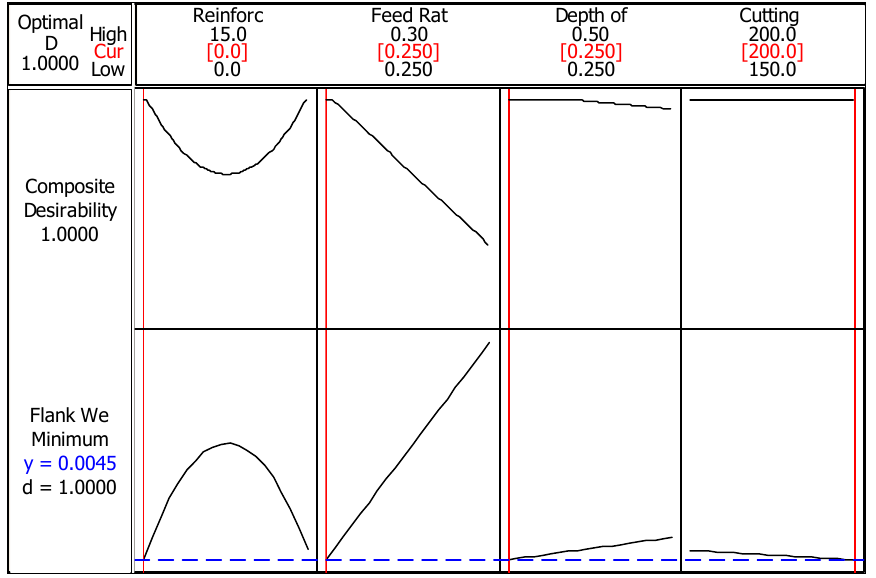
Figure 6. Main effect plots for S/N ratios of flank wear.